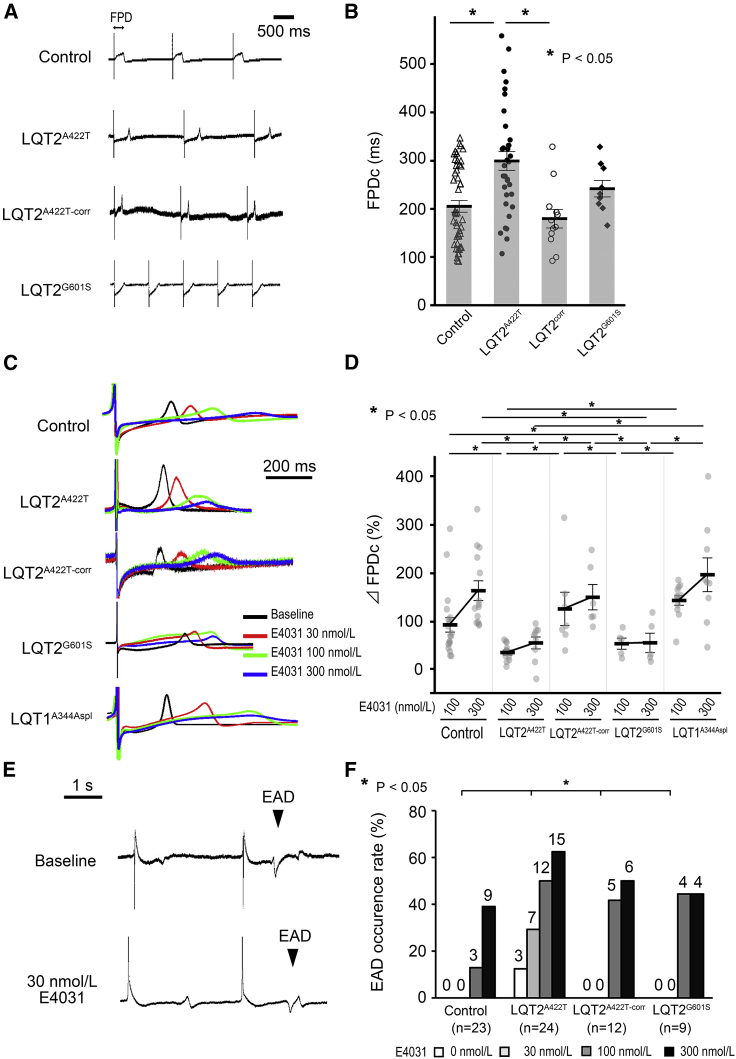
Functional Analysis of iPSC-CMs Using MEA Following IKr Blockade(A) Representative traces of FP in Control-, LQT2A422T-, LQT2A422T-corr-, and LQT2G601S-iPSC-CMs.(B) FPDc baseline data in Control-, LQT2A422T-, LQT2corr-, and LQT2G601S-iPSC-CMs (independent experiments, n = 45, 35, 12, and 9 from independent differentiation experiments, n = 16, 11, 6, and 3, respectively; mean ± SEM; p = 0.001; one-way ANOVA). ∗p < 0.05, Fisher's LSD post hoc test.(C) Representative traces of the FPD following administration of 30 nmol/L (red), 100 nmol/L (green), and 300 nmol/L (blue) E4031.(D) Averaged FPDc ratio before and after E4031 treatment (%ΔFPDc) in Control-, LQT2A422T-, LQT2A422T-corr-, LQT2G601S-, and LQT1A344Aspl-iPSC-CMs. FPDc prolongation upon treatment with 100 and 300 nmol/L E4031 was smaller in LQT2A422T- and LQT2G601S-iPSC-CMs than in Control-, LQT2corr-, or LQT1A344Aspl-iPSC-CMs (independent experiments, n = 23, 24, 12, 9, and 12 from independent differentiation experiments, n = 8, 8, 6, 3, and 3 in Control-, LQT2A422T-, LQT2A422T-corr-, LQT2G601S-, and LQT1A344Aspl-iPSC-CMs, respectively; mean ± SEM; p = 0.025; two-way repeated measures ANOVA). ∗p < 0.05, Fisher's LSD post hoc test.(E) Examples of EADs. EAD documented in a sample of LQT2A422T-iPSC-CMs before E4031 treatment (upper) and following 30 nmol/L E4031 treatment (lower).(F) Percentage of samples in which EADs occurred in Control-, LQT2A422T-, LQT2A422T-corr-, and LQT2G601S-iPSC-CMs. The number on top of each bar shows the number of arrhythmic events. ∗p < 0.05; Pearson's Chi-square test.See also Figure S1.